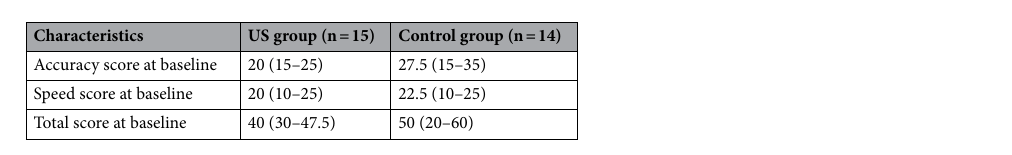
Table 1. Palpation outcome scores for participants at